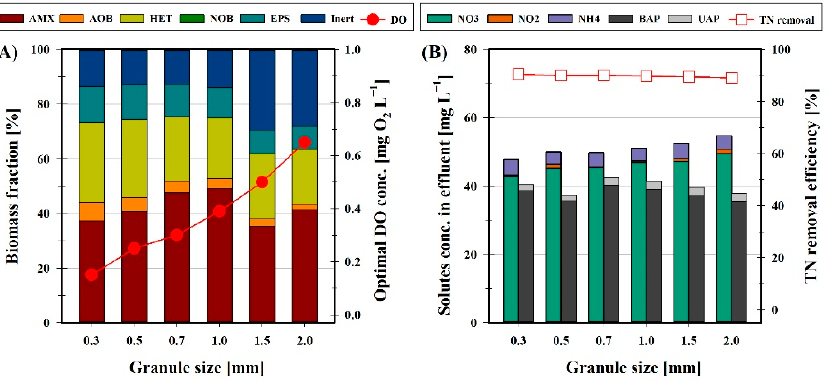
Figure 7. Mode-base analysis for the influence of granule size on heterotrophic growth in the gran- ules: ( A ) biomass fractions and ( B ) nitrogen removal. Note that simulations were performed under different granule diameters with corresponding optimal bulk oxygen concentrations.